Question: In one sentence, what is this figure communicating?
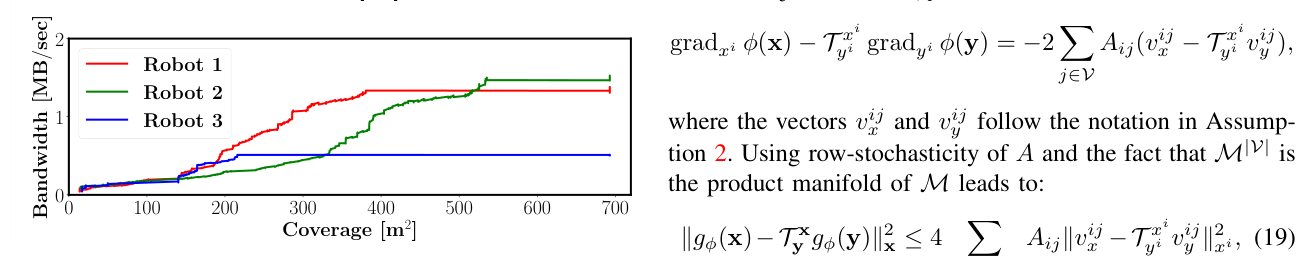
Answer: Multi-robot exploration performance metrics for the real-world experiment. Top: Evolution of the map discrepancy ϕ(h1:3) across the robot network G over time. Bottom: Band- width requirement of each robot for the distributed mapping with respect to coverage.